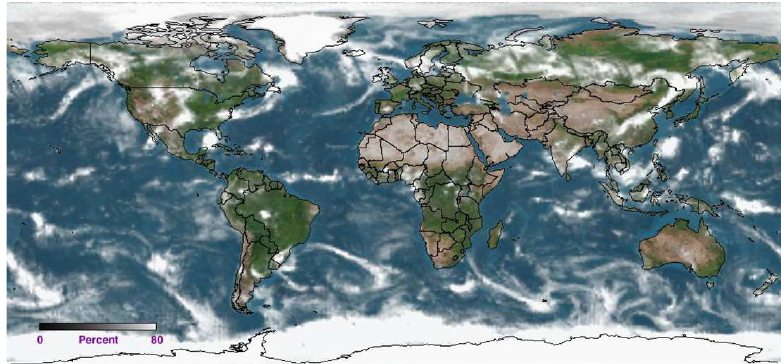
Fig. 2. The geographical distribution of 340 1 1.1nm LER from AURA/OMI for 10 September 2008. The hurricane in the Gulf of Mexico is a Category 4 Hurricane named Ike. The LER data (see black, grey, and white, scale lower left) are superimposed on a MODIS clear-sky color map. The high-altitude storm cloud in the Gulf of Mexico has higher reflectivity (whiter) than midlatitude